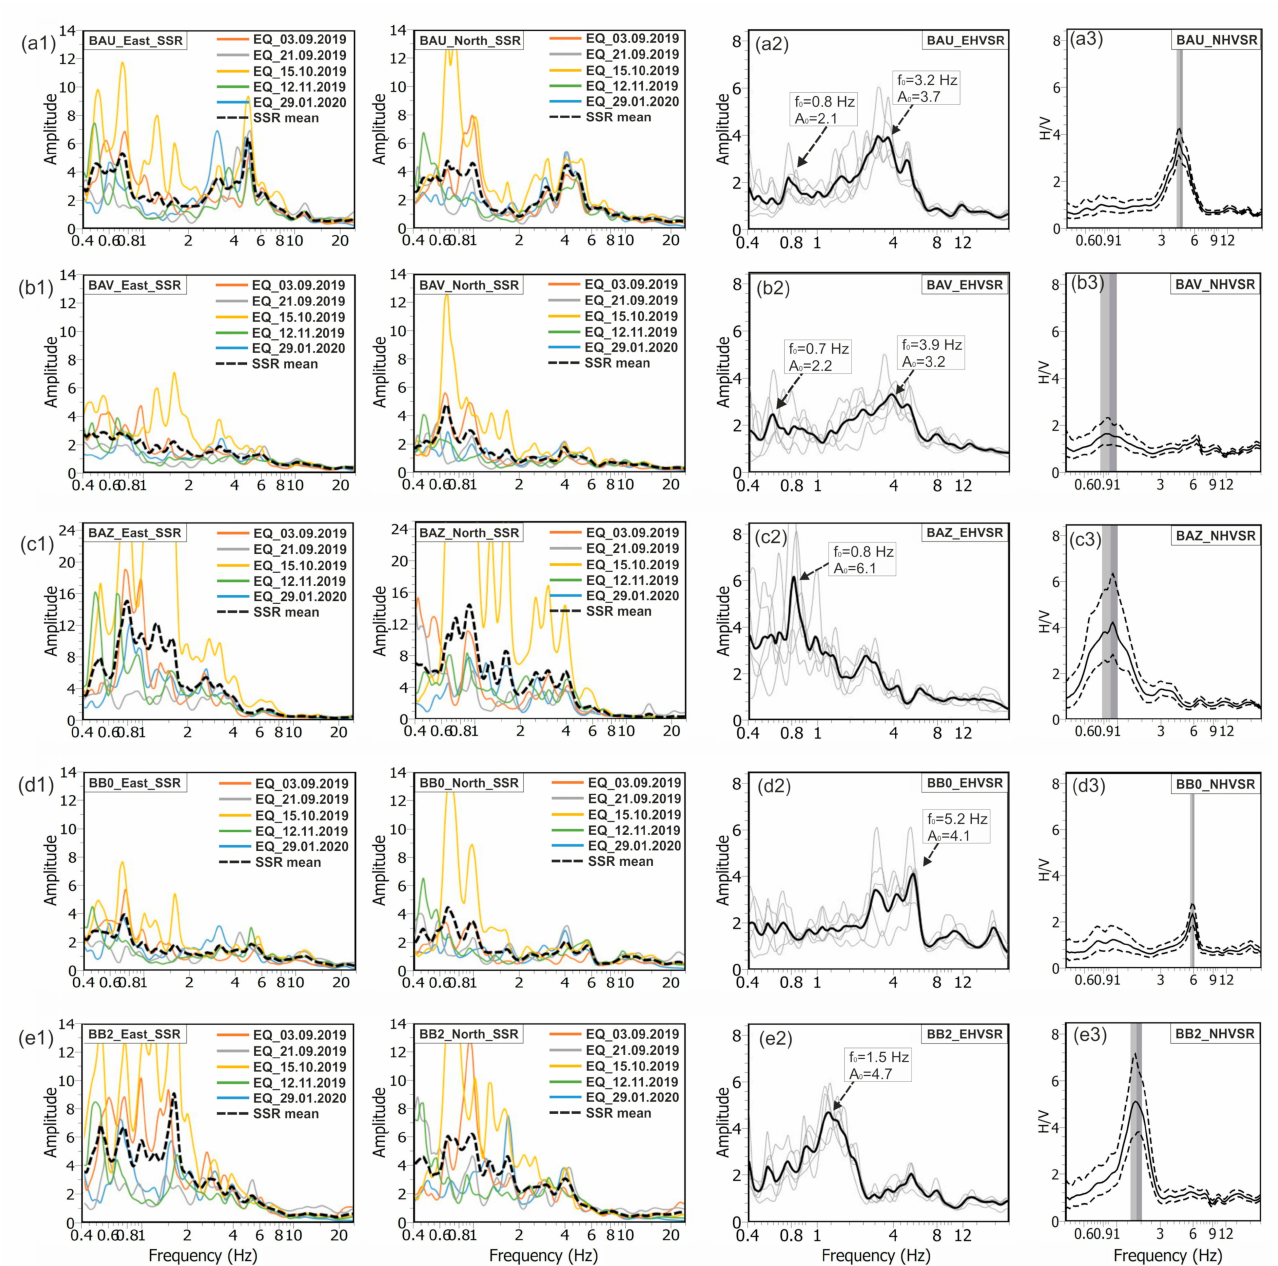
Figure 11. The SSR calculated for the S-wave window ( a1 – e1 ) from five selected earthquakes for the east–west and north– south components at each station and the corresponding spectrum at the DZET (reference station). In addition, ( a2 – e2 ) show the HVSR earthquake (EHVSR) curves and ( a3 – e3 ) show the HVSR noise (NHVSR) curves from each station. In all figures, the black dashed curve shows the average SSR for the east–west and north–south components for five selected earthquakes. Please note the different amplitude range variation for the station BAZ ( c1